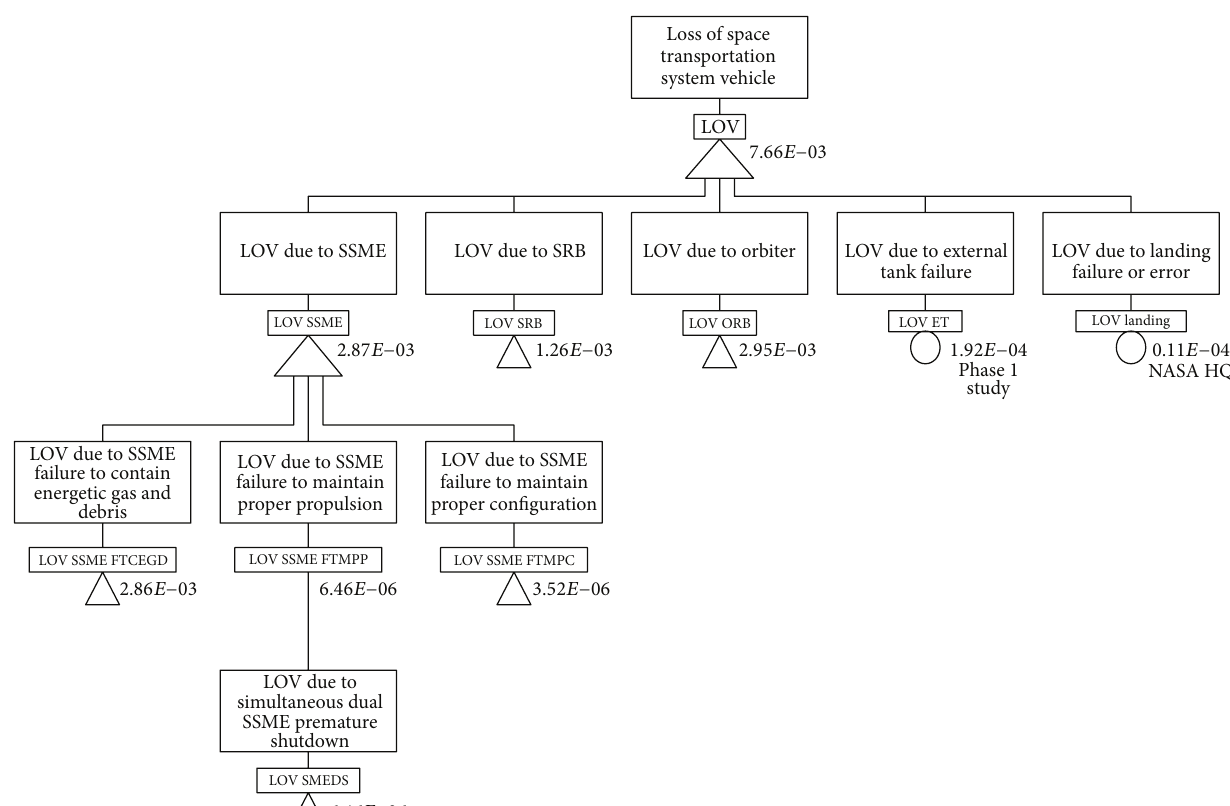
Figure 2: Top of the failure tree adapted from the reliability study of Fragola and Maggio [23], where LOV is loss of vehicle, SSME is Space shuttle Main Engines, SRB is Solid Rocket Boosters, ORB is Orbiter, ET is External Tank, FTCEGD is Failure to Contain Energetic Gas and Debris, FTMPP is Failure to Maintain Proper Propulsion, FTMPC is Failure to Maintain Proper Configuration, and SMEDS is Simultaneous Dual SSME Premature Shutdown. Probabilities of failure are also